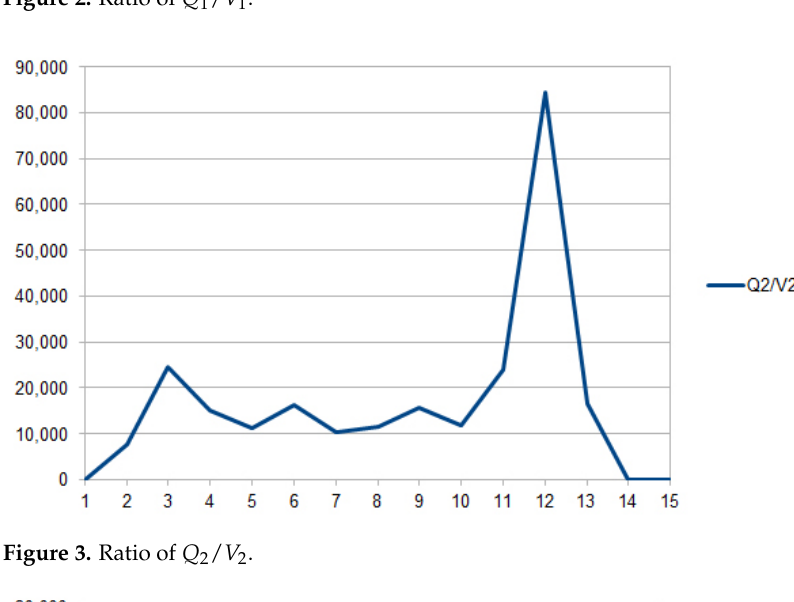
Figure 2. Ratio of Q 1 / V 1 .